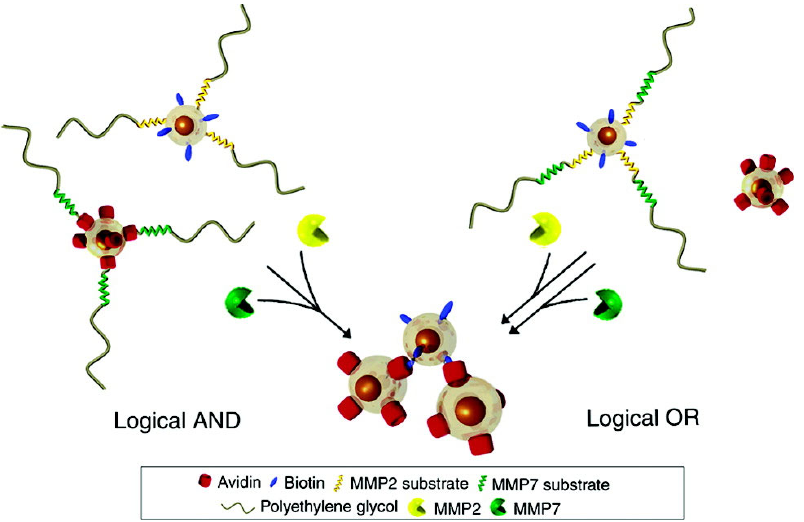
Figure 17. Schematic representation of the assembly of nanoparticles to construct logical AND (left) or logical OR (right) by attachment of protease removable polyethylene glycol polymers (reprinted from [154] with permission of ©2007 American Chemical Society).